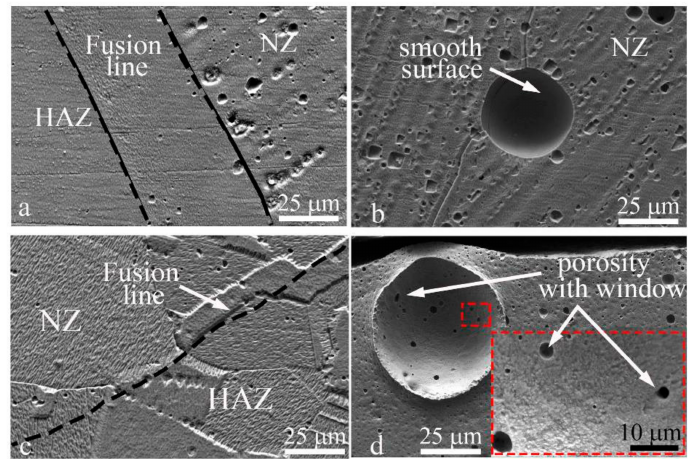
Figure 14. SEM images of porosity at the nugget zone of a GTA spot-welded copper joint made without (0 s USV) ( a ) at the fusion line; ( b ) at the center of NZ; and with 2 s USV; ( c ) at fusion line; and ( d ) at the center of